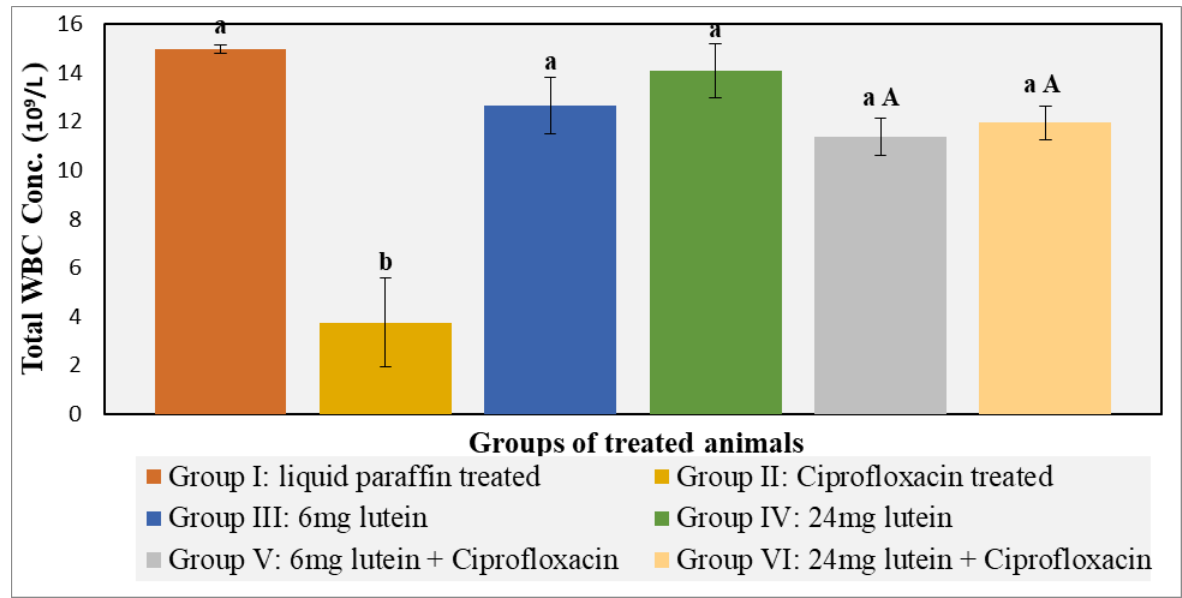
Figure 2. Effects of various treatments on Total WBC counts in rats. Data are expressed as Mean ± SD, n =6. Values with non-identical small letters (a, and b) are significantly different ( P < 0.05). Values with an identical capital letter (A) are non-significantly different ( P >